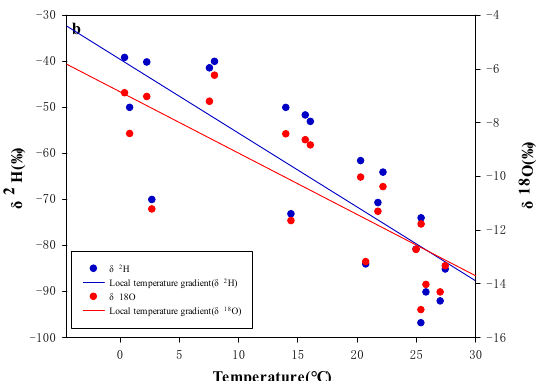
Figure 5. ( a ) The regression line for δ 2 H and δ 18 O in precipitation with respect to the amount of precipitation in the study area. The resulting linear regressions for precipitation, δ 2 H and δ 18 O were represented by δ 2 H = − 0.16 A − 53.76 ( R 2 = 0.8) and δ 18 O = − 0.02 A − 8.87 ( R 2 = 0.67), respectively. ( b ) The resulting linear regressions for the monthly mean temperature, δ 2 H and δ 18 O are represented by